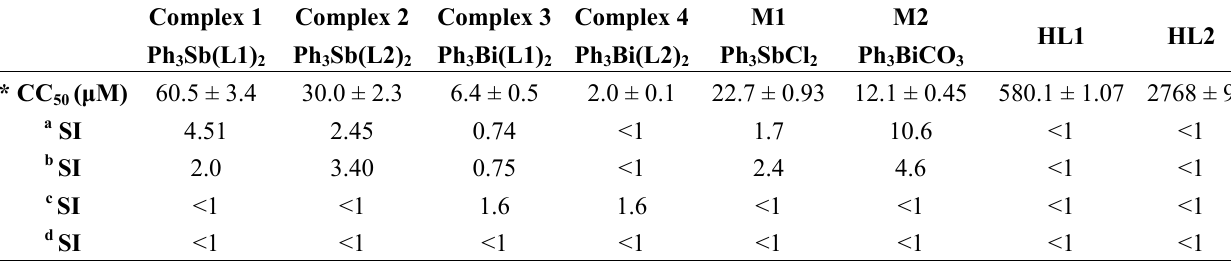
Table 5. In vitro cytotoxicity of complexes 1 – 4 , metal salts Ph the free ligands acetylsalicyclic acid (HL1) and 3-acetoxybenzoic acid (HL2) against mouse peritoneal